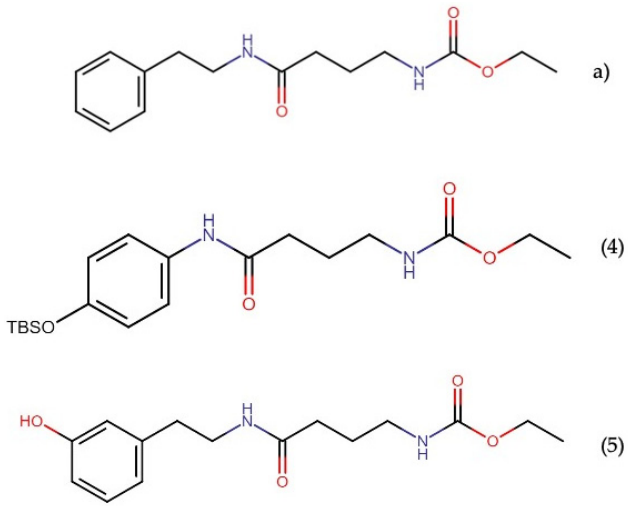
Figure 23. Chemical structures of ( a ) santacruzamate A and derivatives ( 4 ) and ( 5 ).